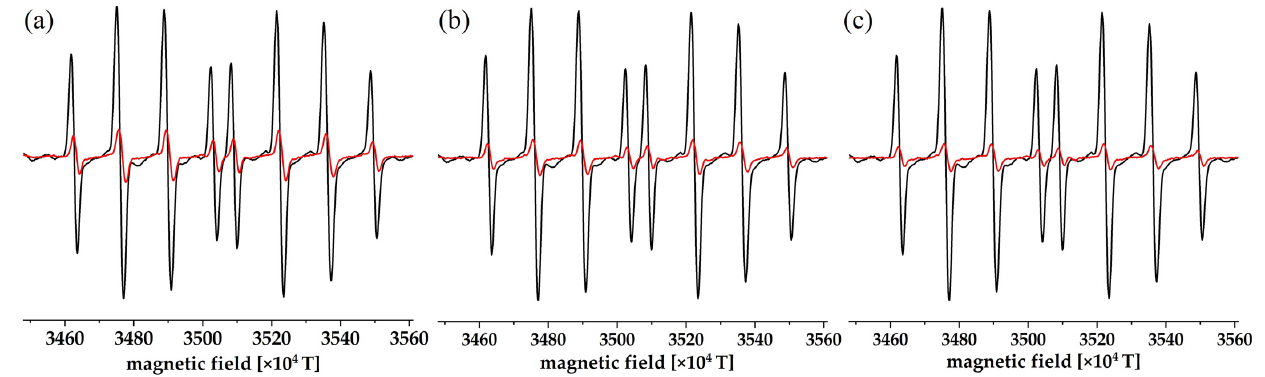
Figure 3. The experimental EPR spectra of DEPMPO − HO • in the presence (red line) and absence (black line) of the compounds ( a ) A 1 –RH, ( b ) A 2 –RH, and ( c ) A 3 –RH.